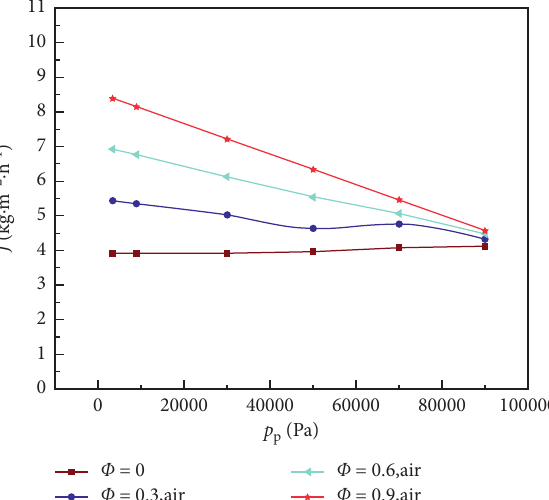
Figure 6: Permeate flux of air bubbling process under different effective enhancement area coefficients ( Φ ) and different pressure of the permeate side. T F,in � 323K, T P,in � 298K, V F,in � 0.145m/s, V P,in � 0.002m/s, P F � P 0 , W NaCl �